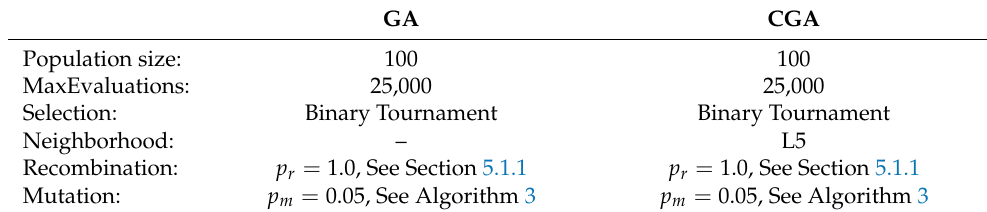
Table 5. Parameter setting for GA and CGA algorithms.